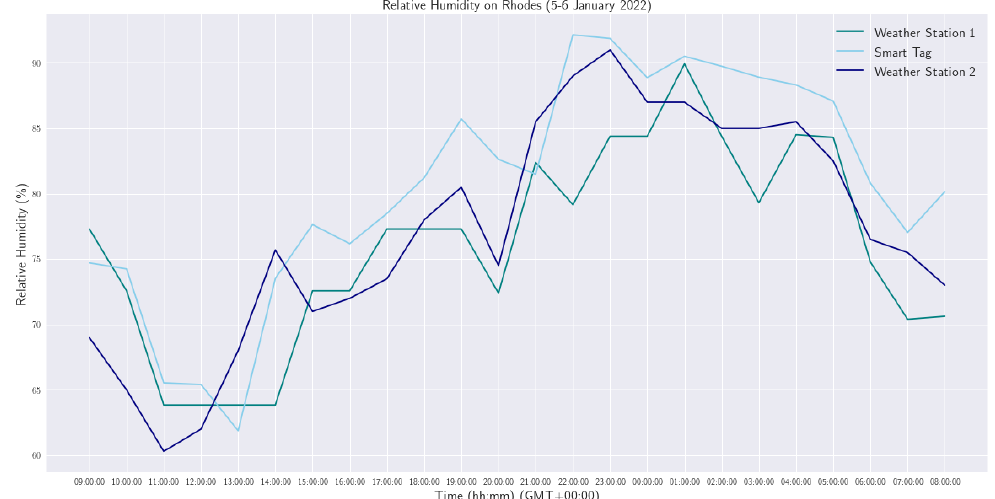
Figure 15. Relative Humidity on Rhodes at 5 January 2022 measured by a Smart Tag and two commercial weather